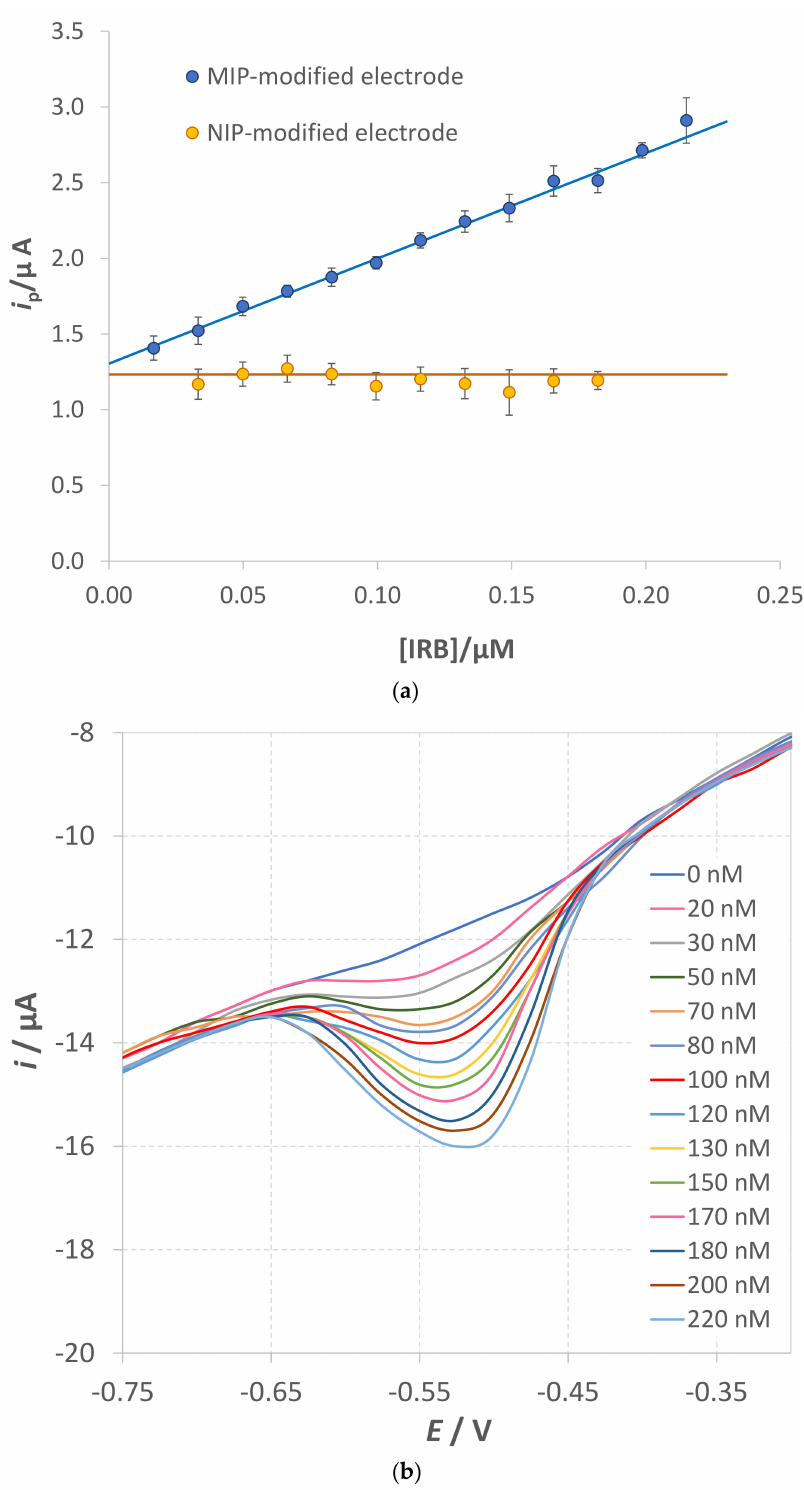
Figure 5. ( a ) Calibration curves of the MIP-modified electrode (blue dots) and NIP-modified electrode (orange dots). ( b ) SW voltammograms of the calibration curve for one MIP-modified electrode. Experimental conditions: SWV in 0.1 M acetate buffer pH 5.5; E start : +1 V; E end : − 1.5 V; frequency: 1 Hz; amplitude: 0.05 V; equilibration time: 300 s. The error bars correspond to the standard deviation of the measurements performed with three